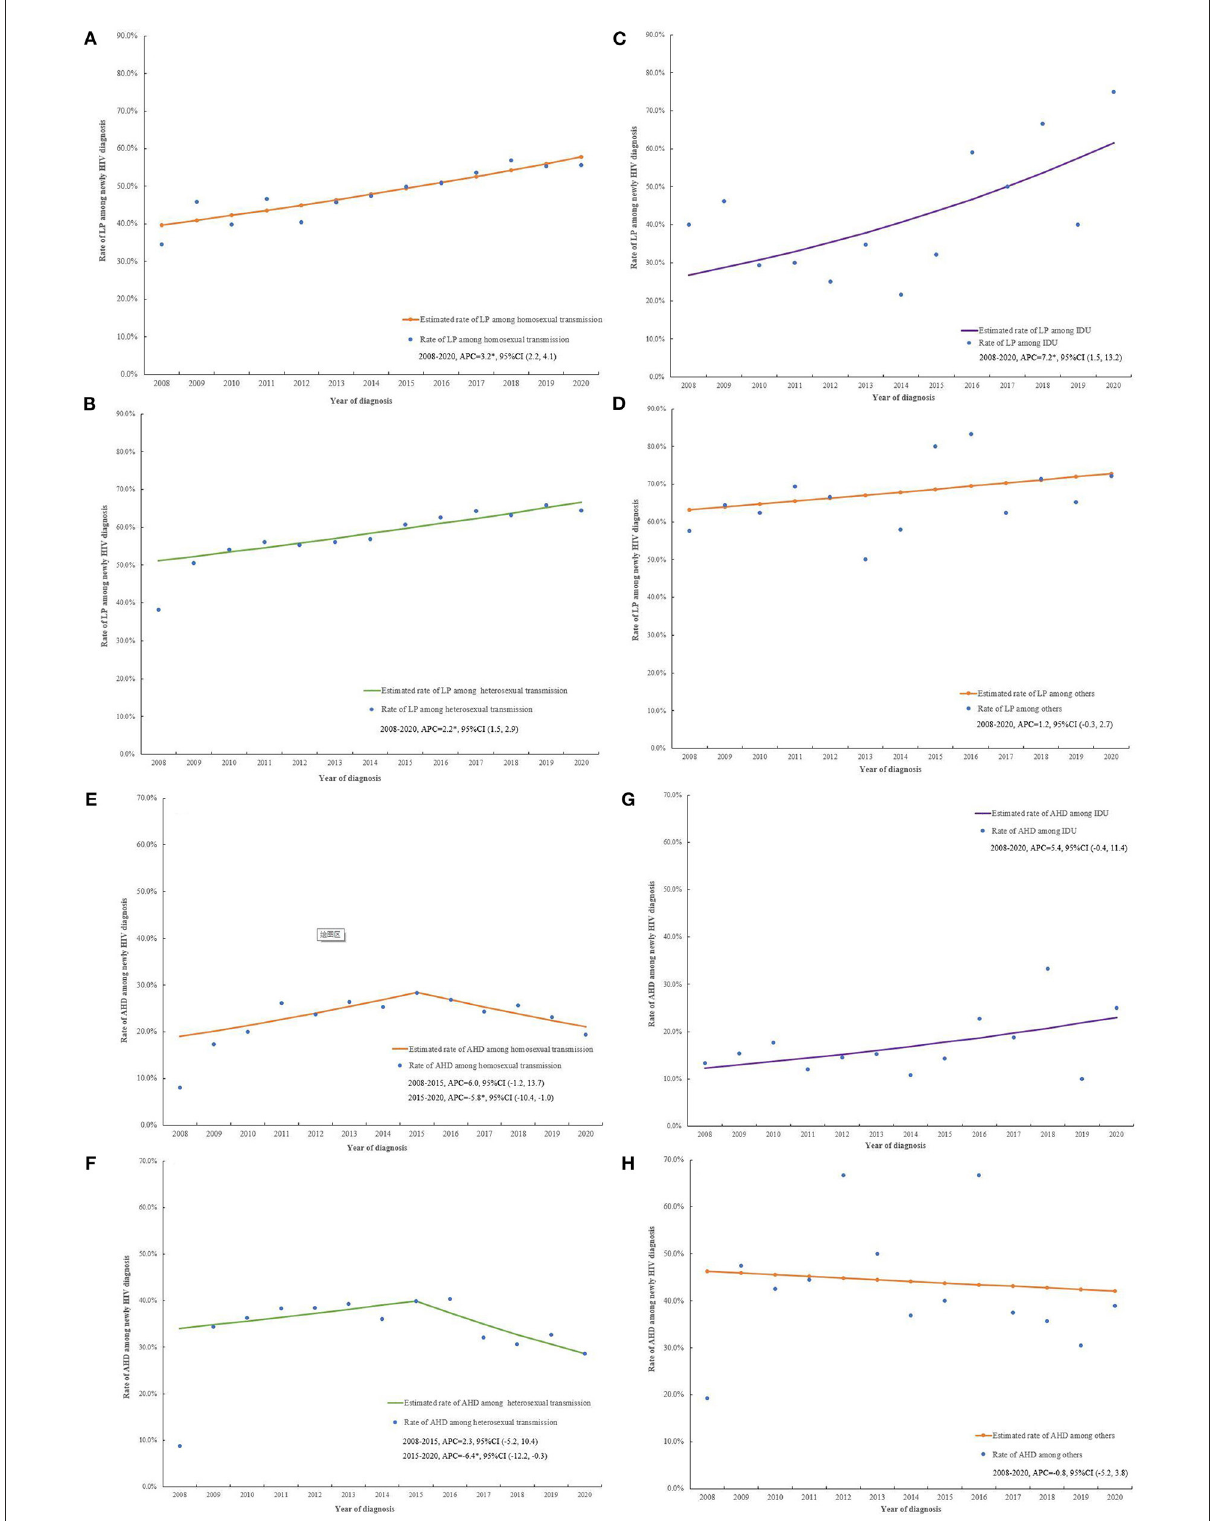
FIGURE3 The trends of original and estimated rate for LP and AHD by transmission routes. The rate trends of LP among homosexual transmission (A) , heterosexual transmission (B) , IDU (C) , and others (D) from 2008 to 2020 in Jiangsu. The rate trends of AHD among homosexual transmission (E) , heterosexual transmission (F) , IDU (G) , and others (H) from 2008 to 2020, in Jiangsu, China. LP, late presentation; AHD, advanced HIV disease; APC, annual percentage change; CI, confidence interval; * P <